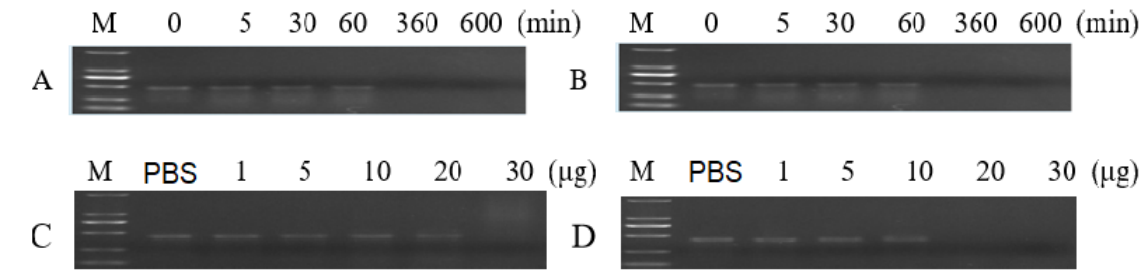
Figure 3. Degradation of dsRNA by the total proteins extracted from the gut or hemolymph at 28 ◦ C. ( A ) Incubation of 120 ng dsRNA with 10 µ g of total gut proteins for different times. ( B ) Incubation of 120 ng dsRNA with 10 µ g of total hemolymph proteins for different times. ( C ) Incubation of 120 ng dsRNA with 1–30 µ g of total gut proteins for 5 min. ( D ) Incubation of 120 ng dsRNA with 1–30 µ g of total hemolymph proteins for 5 min.